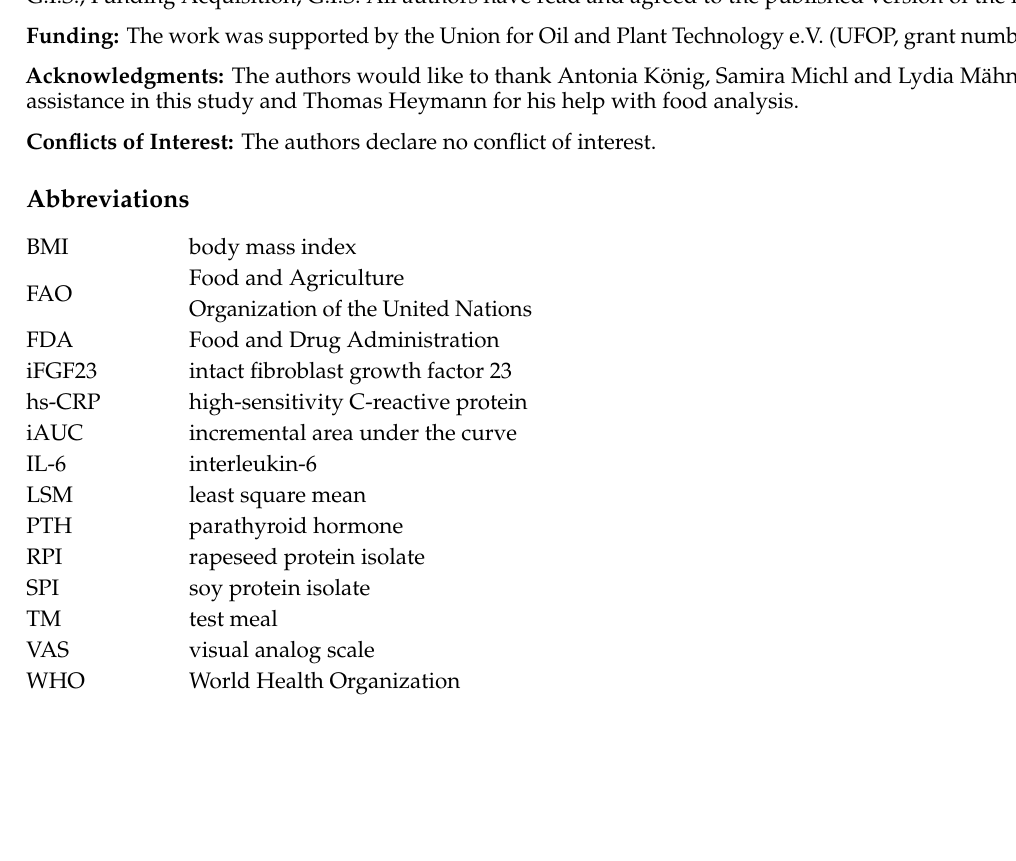
Figure S1: Design of the crossover study, Figure S2: Postprandial blood pressure and heart rate, Figure S3: Postprandial dispensable amino acid response, Table S1: Baseline amino acid concentrations of the study participants, Table S2: iAUC and confidence intervals for plasma parameters. Table S3: iAUCs and confidence intervals of plasma amino